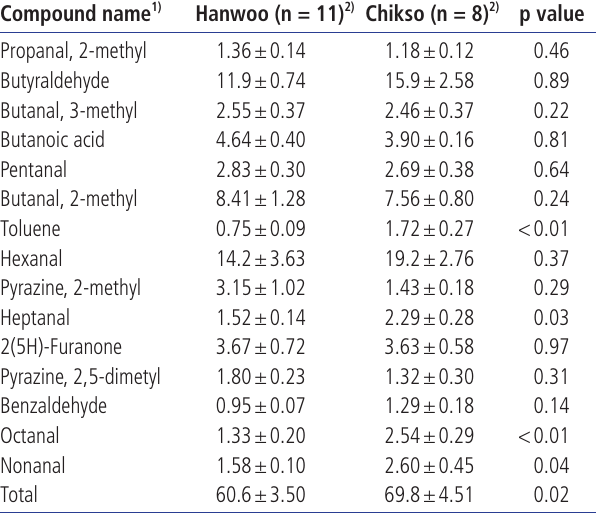
Table 4. Aroma volatiles (area unit ×10 6 ) of roasted strip loin from Hanwoo and Chikso steers finished under same